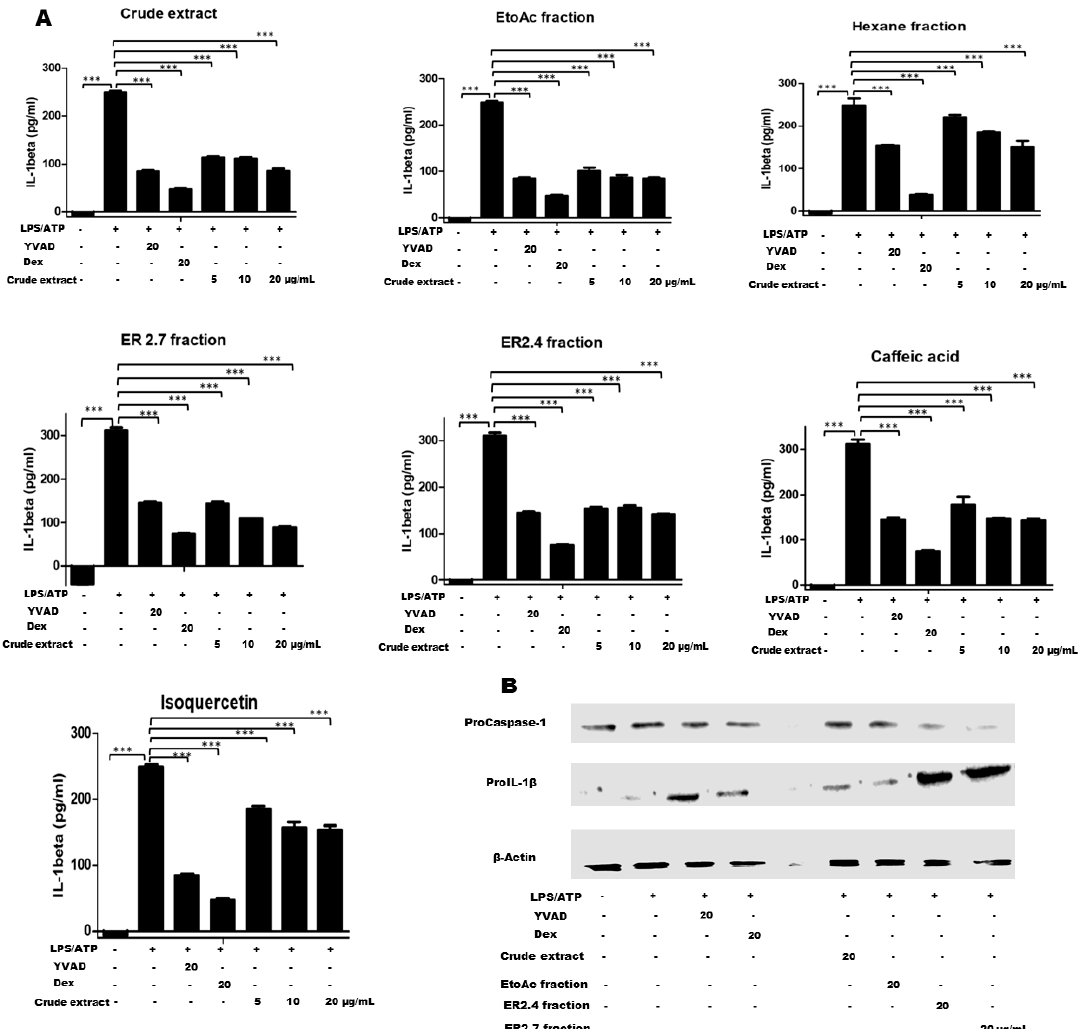
Figure 3. Inhibition of IL-1 β production by H. noldeae constituents. ( A ) PMA-differentiated cells were pretreated with the indicated plant constituents at the concentration range shown for 1 h, and then primed by LPS (1 µg/mL) for 3 h. Concentrations of 20 µM YVAD and 20 µg/mL Dex were used as controls. Cells were then stimulated by ATP (5mM) for additional 1 h. Supernatants were harvested and kept at − 70 ◦ C before analysis. For the ELISA analysis, samples were diluted 10 times in the assay diluent. The concentration of IL-1 β in the culture supernatant was measured using a human IL-1 β Enzyme linked immunosorbent assay (ELISA) kit (Invitrogen / Thermofisher, Waltham, MA, USA) according to the manufacturer’s instructions. For each experiment, the amount of IL-1 β produced without any pretreatment was considered as 100% and the remaining treatments were calculated as (Treatment/LPS) × 100. The results are presented as the mean ± SD of a triplicate from a representative of three independent experiments ( n = 3). A one-way ANOVA, followed by Benforroni’s multiple comparison test, was used to compare the sample groups. *** stands for p < 0.0001. ( B ) Immunoblotting of cell lysates by anti-ProIL-1 β (Cell signaling Technology, Danvers, MA, USA) or anti-Pro caspase-1 (Abcam, Cambridge, UK) was done twice according to the manufacturer’s instructions. Membranes were then stripped, reprobed with anti- β -Actin antibodies and exposed again to detect the internal β -Actin standard.